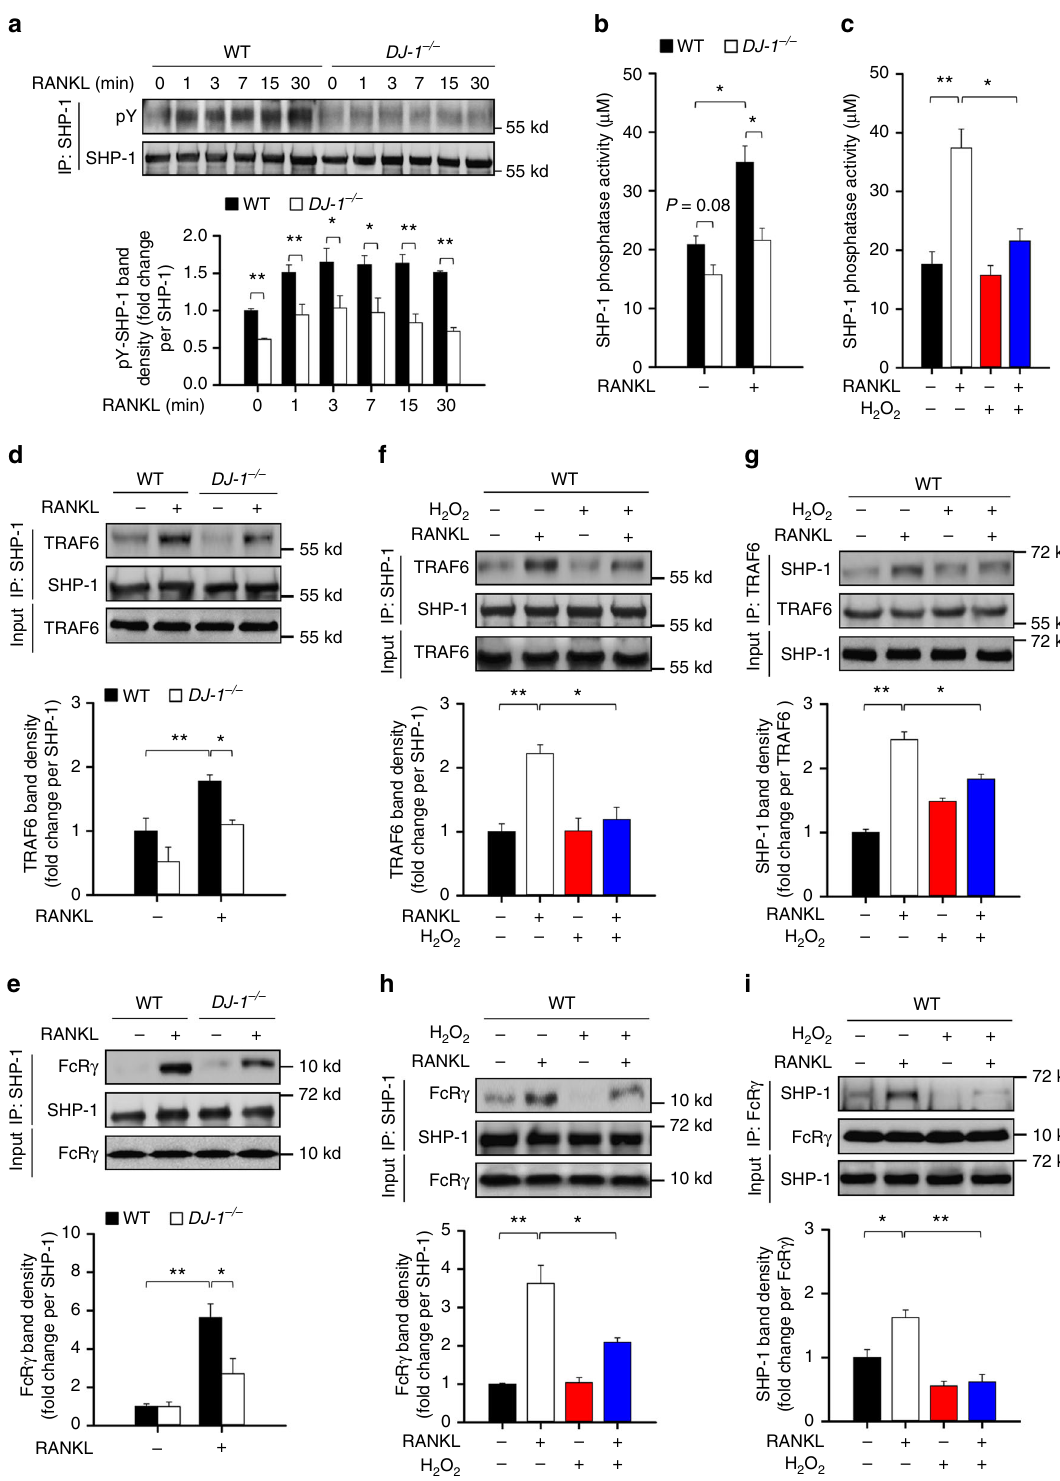
Fig. 5 DJ-1 de fi ciency inhibits SHP-1 in BMMs. a Representative immunoblot images (upper panel) and densities (lower panel) for phosphorylated forms of SHP-1 after immunoprecipitation of SHP-1 shown as the mean ± s.e.m. from three independent experiments in triplicate. ** p < 0.01, * p < 0.05 by Student ’ s t -test. b , c Activity of immunoprecipitated SHP-1 in WT or DJ-1 − / − BMMs stimulated by RANKL for 7 min with or without H